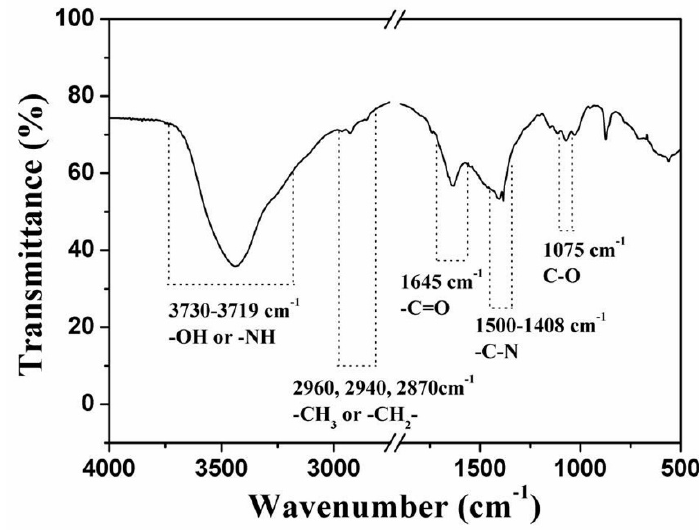
Figure 11. FTIR results for the dactylopodite exoskeleton. Figure11. FTIR results for the dactylopodite exoskeleton. Figure11. FTIR results for the dactylopodite exoskeleton.